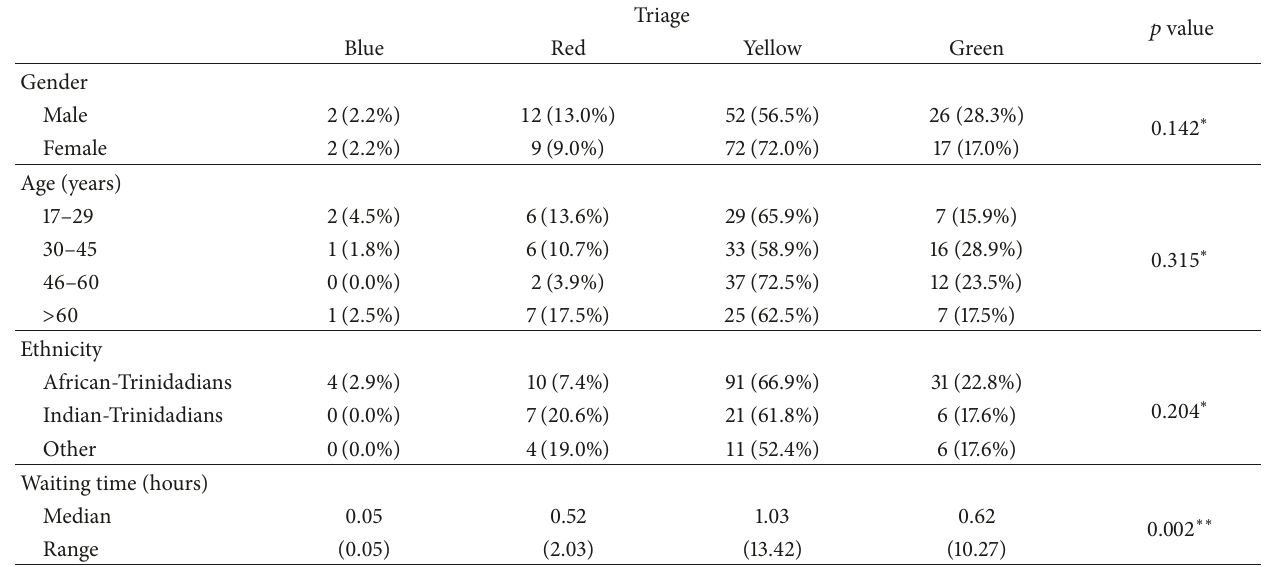
Table 1: Patients’ factors (age, sex, and ethnicity) and waiting times according to triage